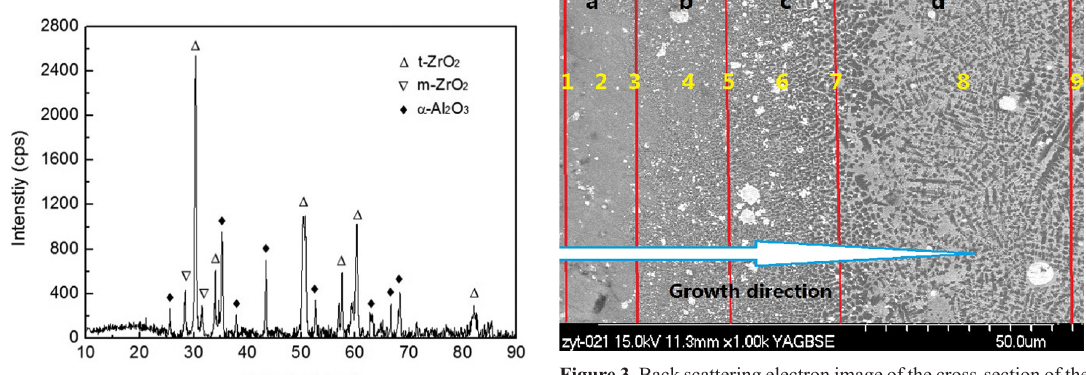
Figure 3. Back scattering electron image of the cross-section of the